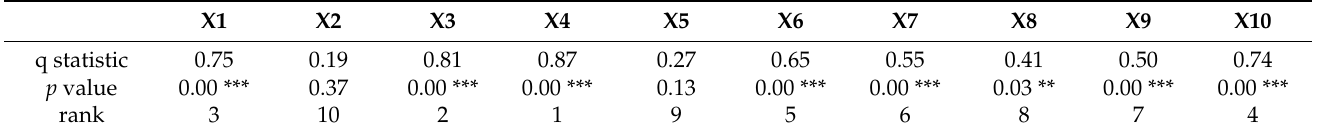
Table 5. Factor detection results of driving factors of